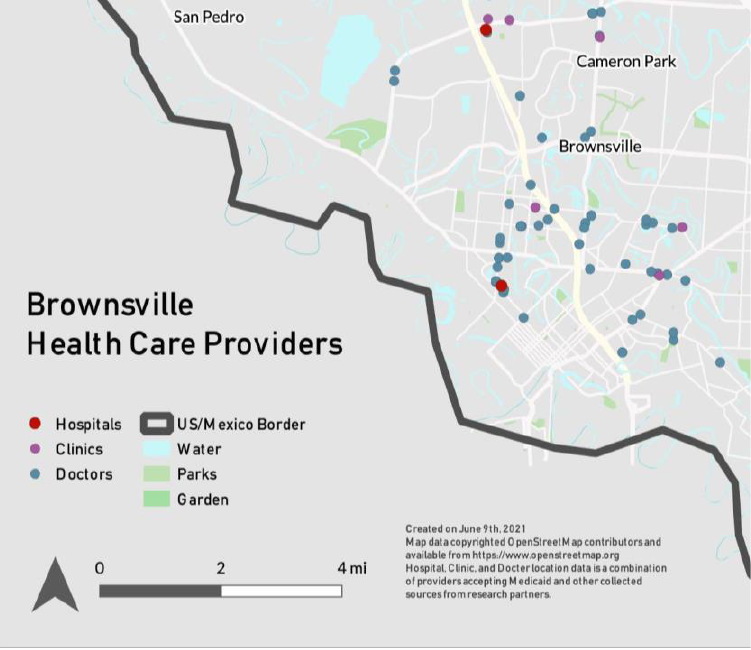
Figure 1. Map of health care providers in Brownsville, Texas.